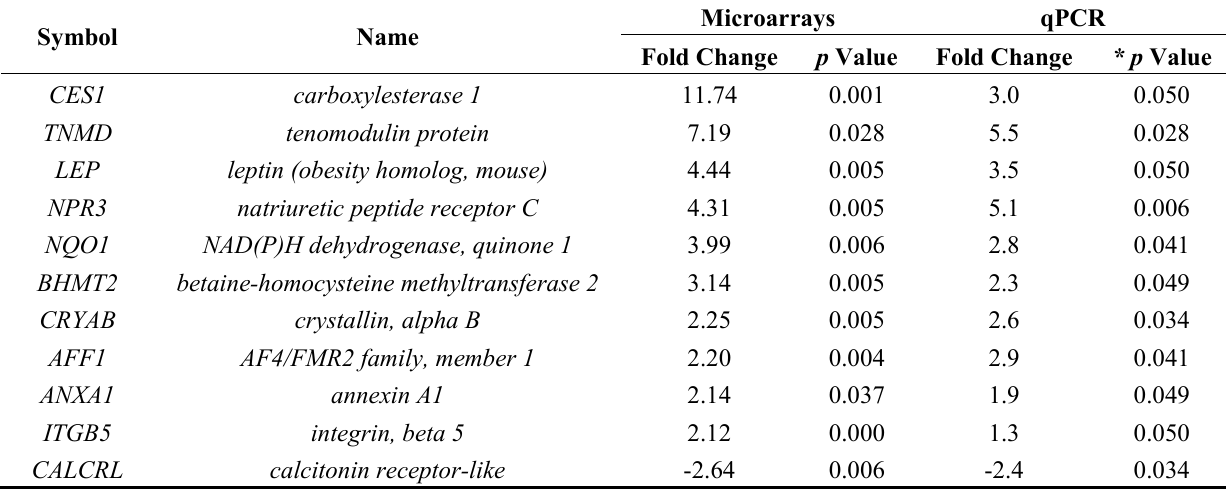
Table 2. Genes with altered expression, confirmed by qPCR, in the AT of obese prepubertal children compared to normal-weight